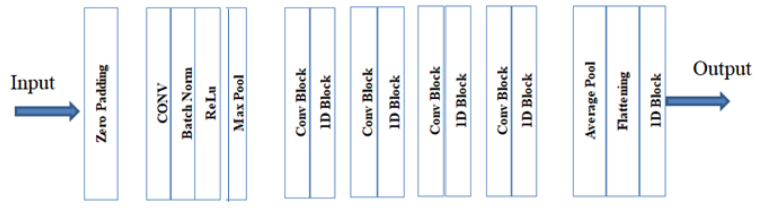
Figure 6. The architecture of ResNet-50.